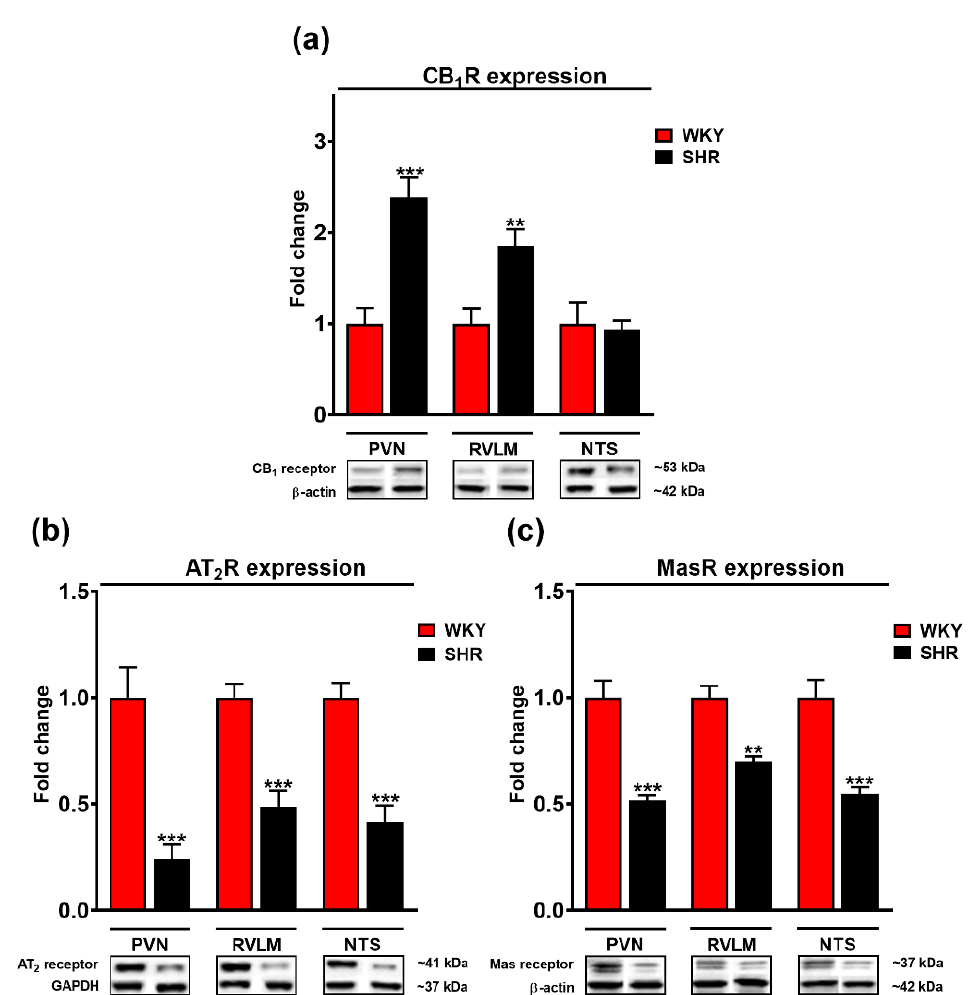
Figure 7. Fold change of cannabinoid CB 1 ( a ), AT 2 ( b ) and Mas ( c ) receptors and representative Western blots of the paraventricular nucleus of hypothalamus (PVN), rostral ventrolateral medulla (RVLM) and nucleus tractus solitarii (NTS) in Wistar Kyoto (WKY) and spontaneously hypertensive rats (SHR). β -actin or glyceraldehyde-3-phosphate dehydrogenase (GAPDH) served as loading control. Results presented as mean ± SEM ( n = 6). ** p < 0.01, *** p < 0.001 compared to WKY. Uncropped Western blot images can be seen in Supplementary Materials, file Figure